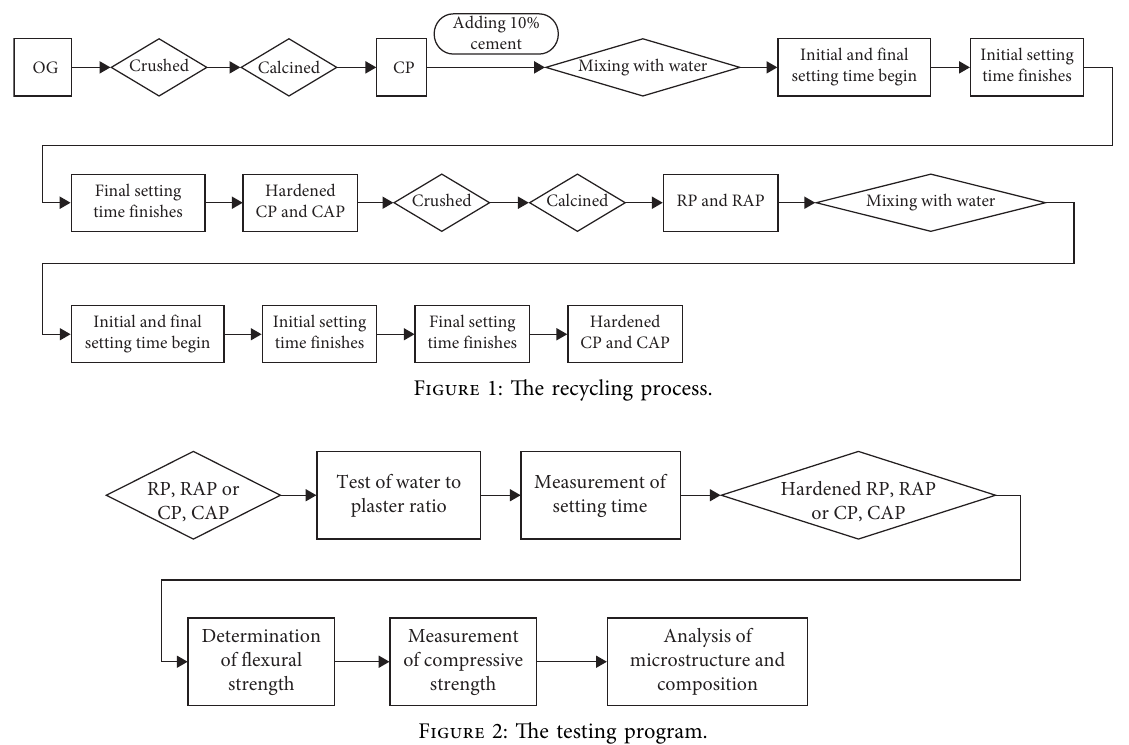
Figure 2: The testing program.